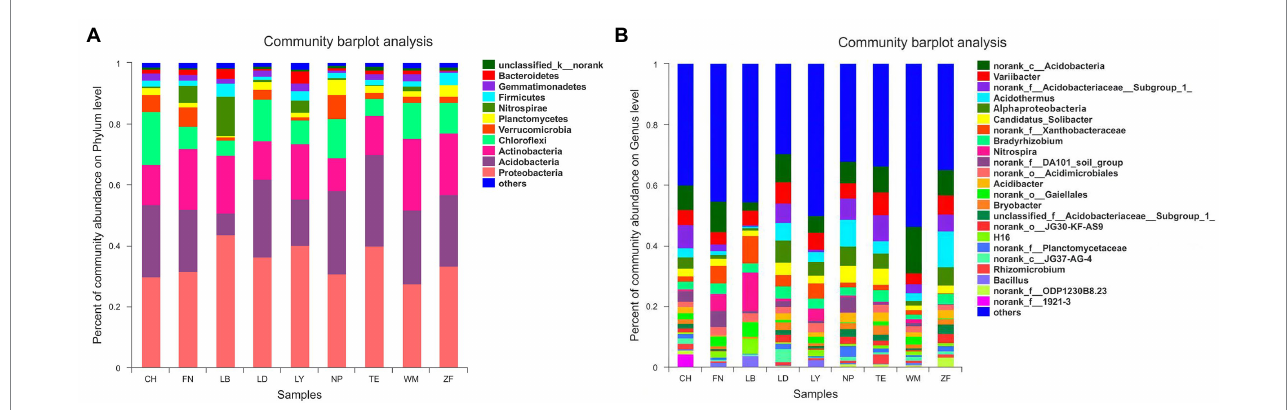
FIGURE 2 Rhizobacterial community structure across nine sample sites. Phylum-level (A) and Genus-level (B) . The color of the column represents the different genera, and the length of the column represents the proportion size of the genus. The species with <0.01% abundance were classified together as “others.” “norank” represent “unidentified” bacterial